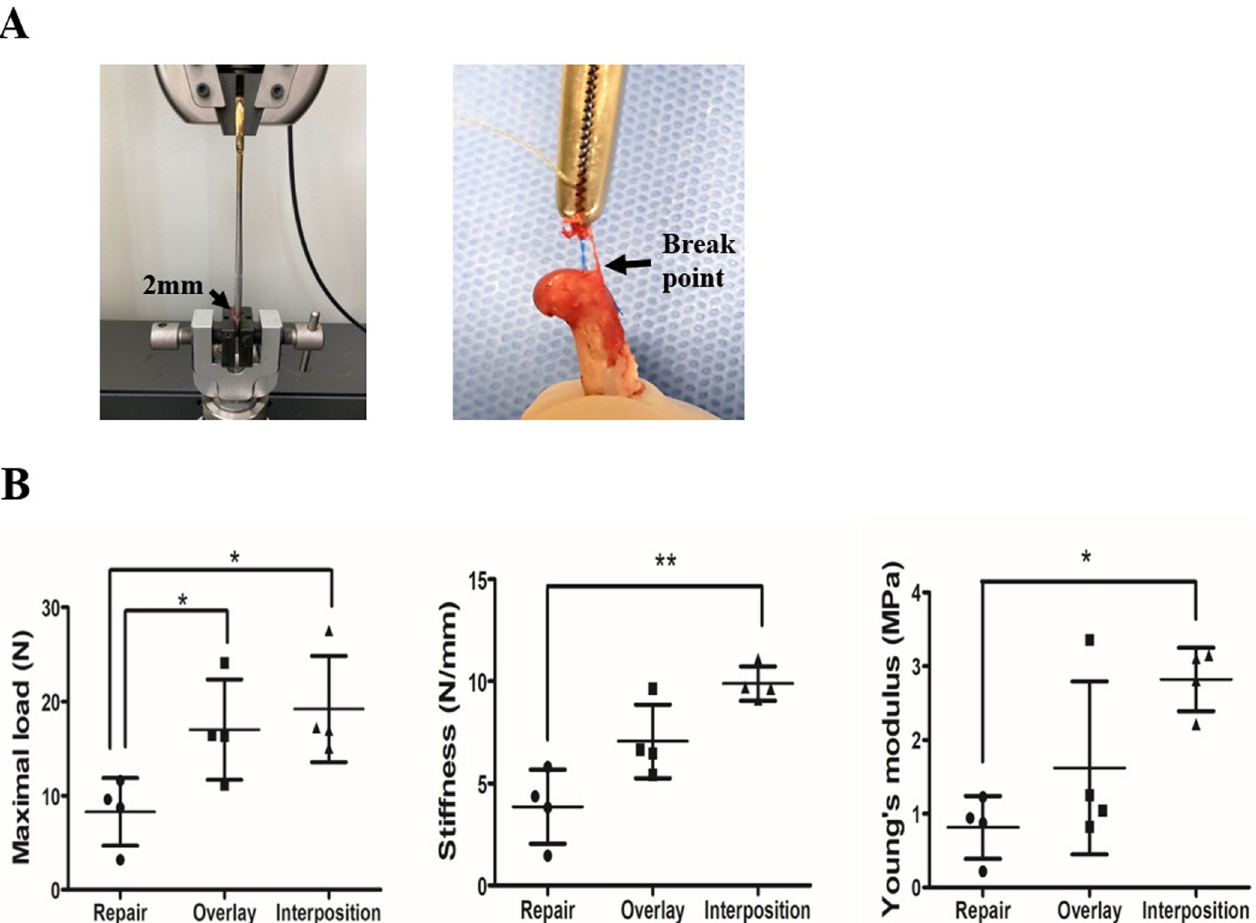
Fig 7. Biomechanical analysis of the application of cell sheets. (A) The image shows a tensile test device (left) and a mode of failure by tendon tearing at the enthesis (right). The 2 mm above from the junction was fixed, and a gradient tension of 1 mm/min was applied. (B) Three graphs indicate the maximal load, stiffness, and Young’s modulus of the tendon-to-bone interface. Error bars represent standard deviation. � P < 0.05, �� P < 0.01 (n = 4).